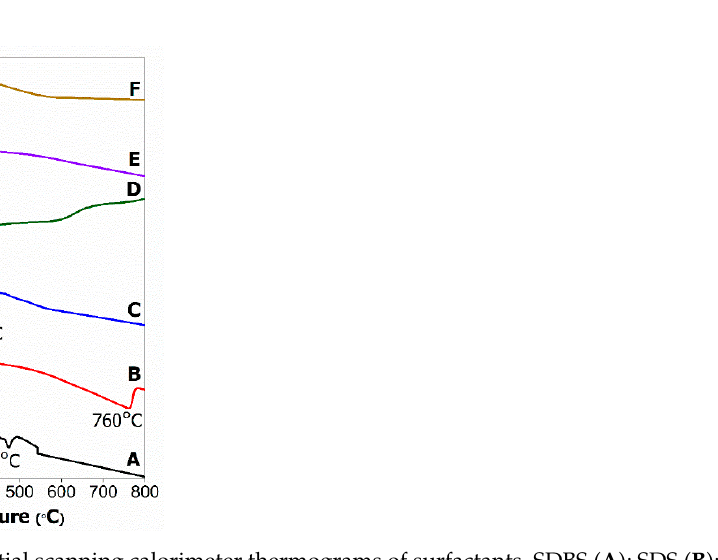
Figure 5. The differential scanning calorimeter thermograms of surfactants, SDBS ( A ); SDS ( B ); T80 ( C ), and their hexaconazole-micelle nanodelivery systems: ( D ) HMBS; ( E ) HMDS; and ( F ) HMT.